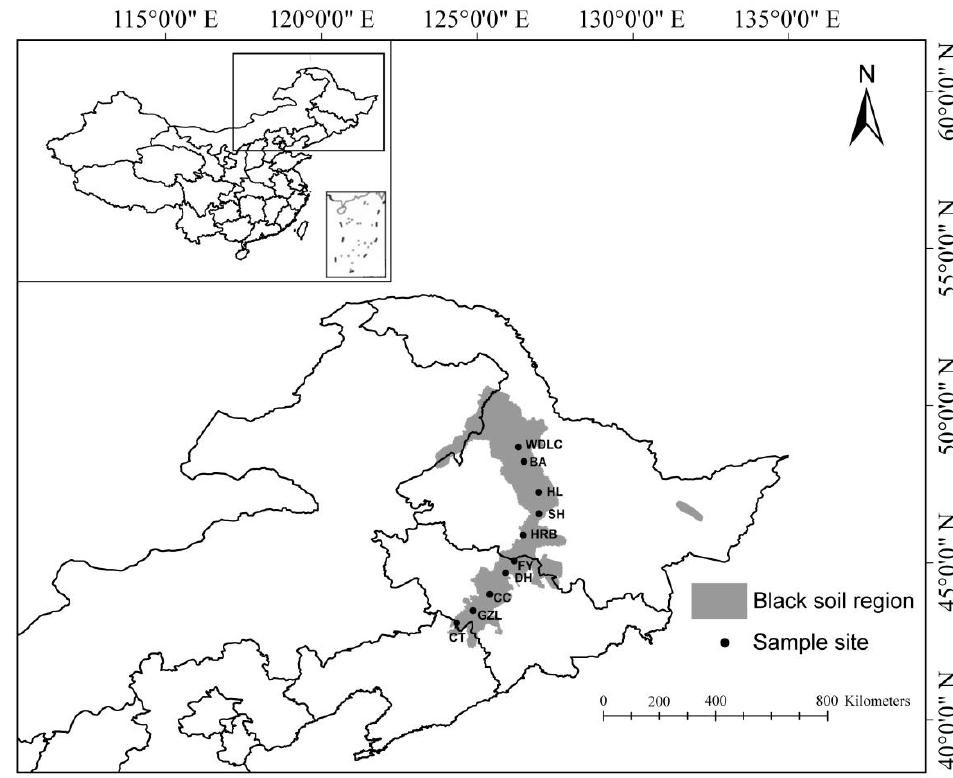
Figure 1. Ten soil sample locations in the black soil region of northeast China. The gray region indicates the representative black soil region of northeast China. The black circles represent the sampling sites: Wudalianchi (WDLC), Beian (BA), Hailun (HL), Suihua (SH), Harbin (HRB), Fuyu (FY), Dehui (DH), Changchun (CC), Gongzhuling (GZL), and Changtu (CT).